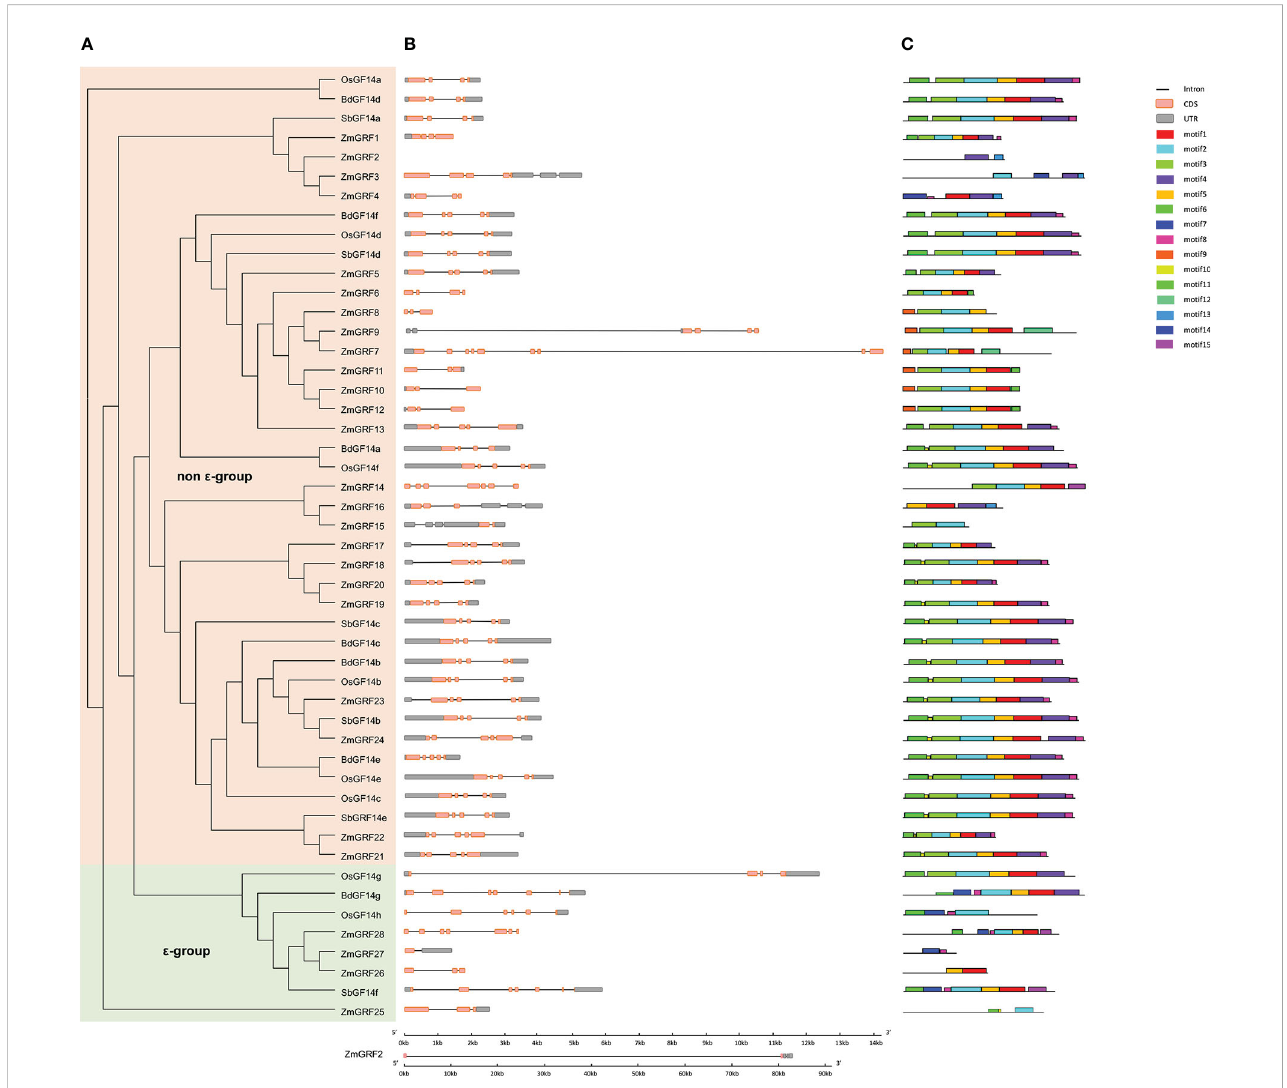
FIGURE 2 Phylogenetic tree, motif, and gene structure of maize, sorghum, brachypodium, and rice. (A) . The phylogenetic tree of four plants. non - ϵ group and ϵ group indicate the two 14-3-3 subfamilies. 14-3-3s from maize ( ZmGRF1 to ZmGRF28 ), sorghum ( SbGF14a to SbGF14f ), brachypodium ( BdGF14a to Bd GF14g ), and rice ( OsGF14a to OsGF14h ). (B) . Gene structure of four plants. Exons are indicated by pink boxes, introns are indicated by single lines, and gray boxes represent untranslated regions (UTR); (C) . Motifs ’ analysis. Different colors represent different